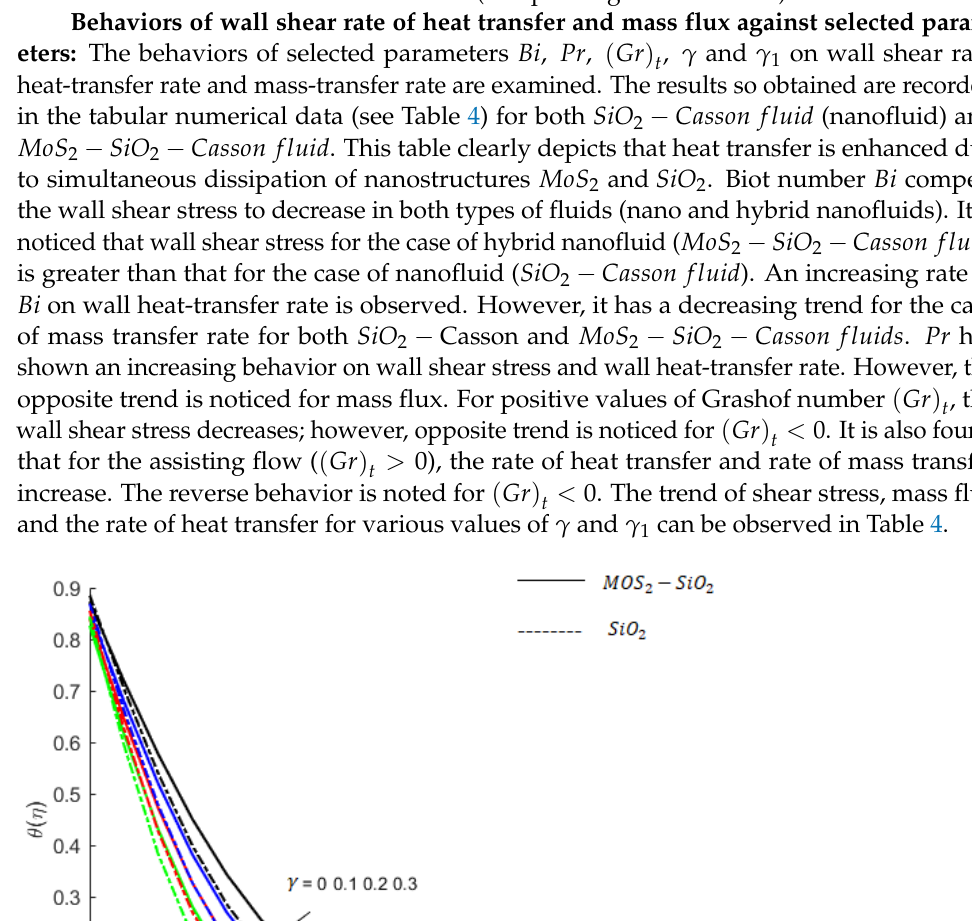
Figure 11. Influence of 𝑆𝑐 on concentration when 𝑀 = 0.9, 𝑃𝑟 = 0.9, 𝐸𝑐 = 0.2, 𝐾 = 0.1, 𝐸𝑖 = 0.1, 𝐵𝑖 = 0.05, 𝛽 ∗ = 0.1, 𝛾 = 0.1, 𝛾 (cid:2869) = 0.1 . Concentration of fluid particles and solutal relaxation time: The effects of thermal relaxation time on the temperature of fluid particles are similar to the impact of solutal relaxation time on the concentration field (compare Figures 10 and 12).